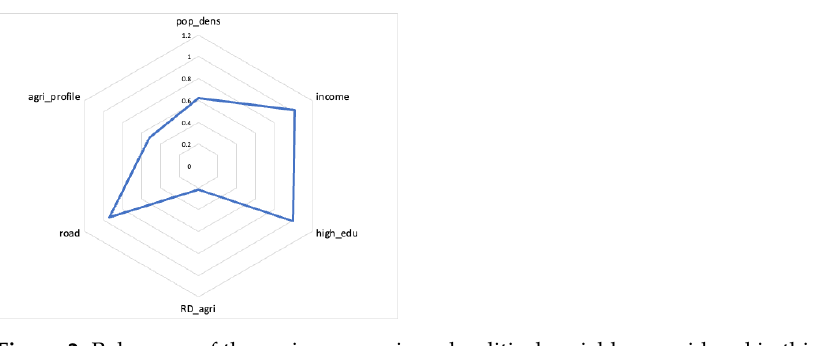
Figure 2. Relevance of the socio-economic and political variables considered in this study, based on the sum of the correlation coefficients.